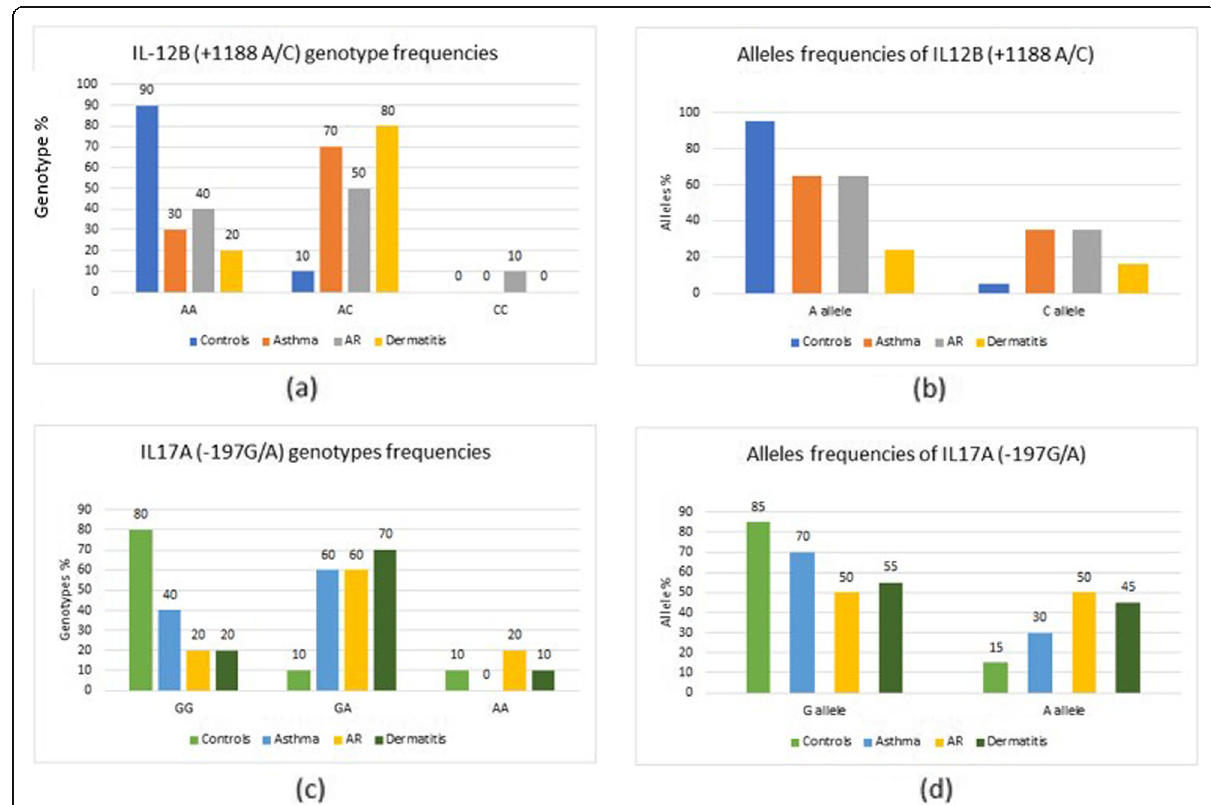
Fig. 6 a , b Genotypes and alleles frequencies of IL12B (+1188 A/C) in patients ’ subgroups and controls. c , d Genotypes and alleles frequencies of IL17A ( − 197G/A) in patients ’ subgroups and controls. Polymorphisms are represented as a